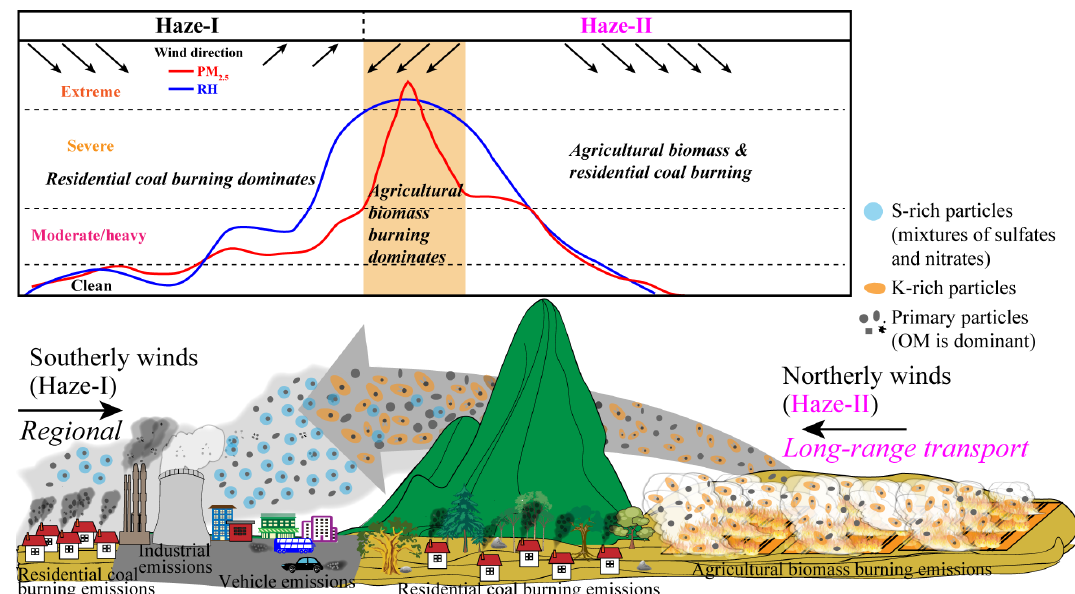
Figure 8. Schematic diagram of Haze-I and Haze-II formation in northeast China during winter. The major emission sources and haze formation processes are